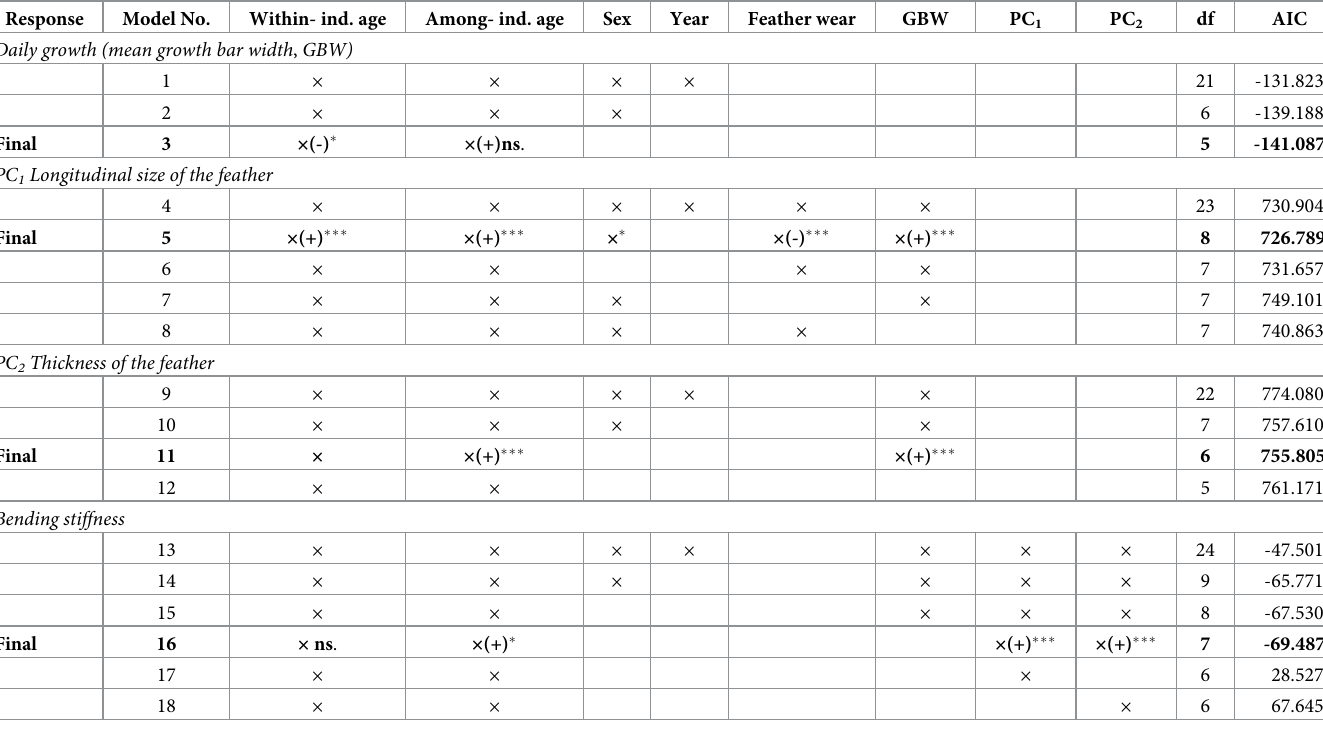
Table 1. Modelling the size, width, and bending stiffness of Sand Martin feathers. Response Model